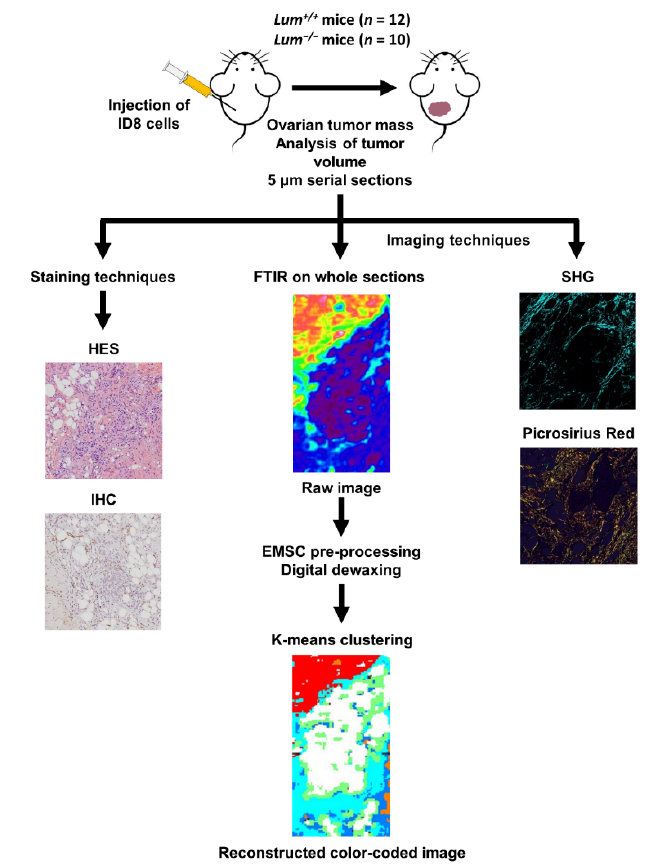
Figure 1. Workflow showing the histology, the immunohistochemistry of formalin-fixed paraffin- embedded ID8 ovarian tumor sections, SHG imaging, Picrosirius red staining (polarized light), and analysis of FTIR images using common K-means clustering.